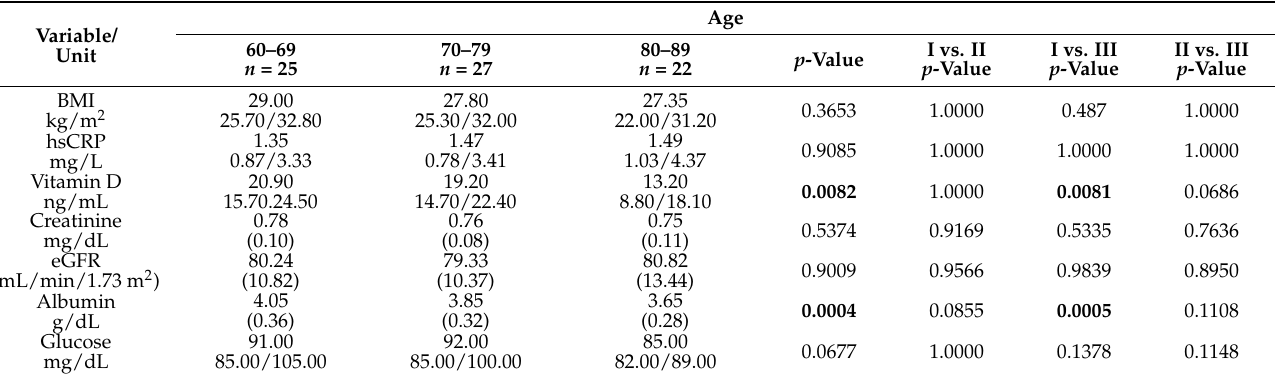
Table 5. Patients’ clinical characteristics according to